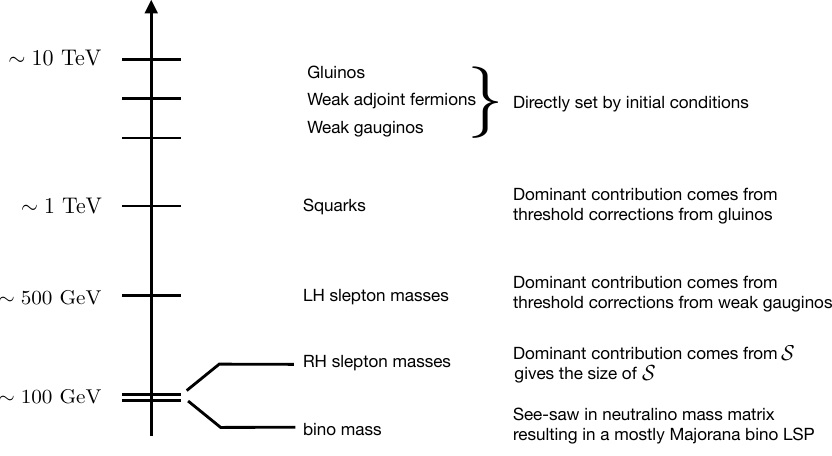
Figure 3 . A schematic diagram of the spectrum to show various